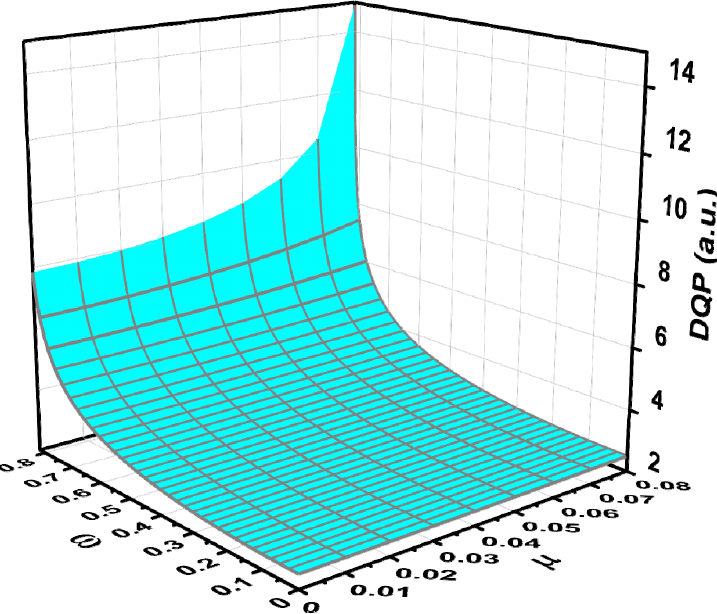
Figure 2. The dynamic quadrupole polarizability (DQP) as a function of the screening parameter and frequency.